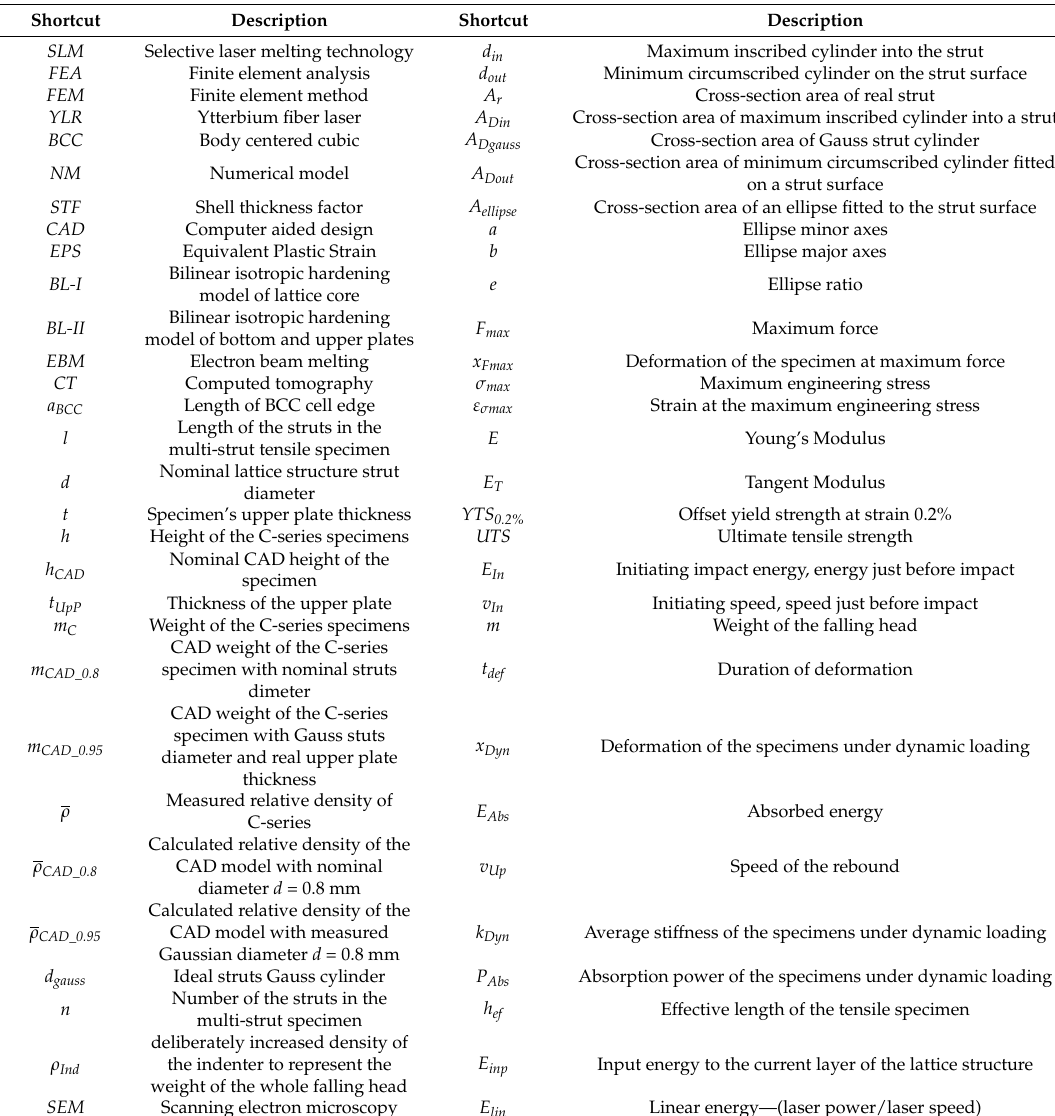
Table 1. The list of used